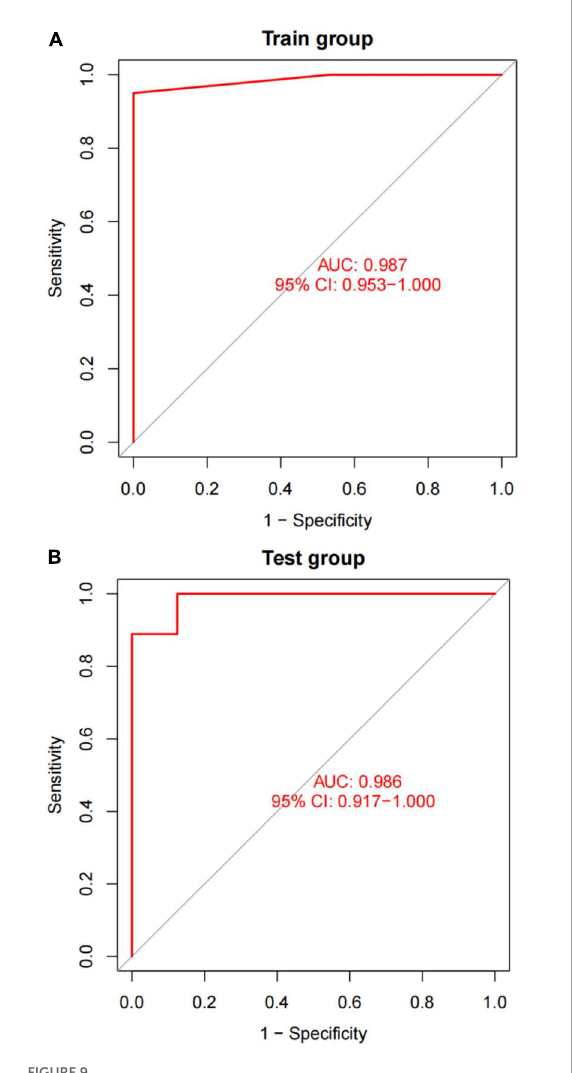
FIGURE9 A plot of the results of AUC verification. (A) AUC verification in the training dataset. (B) AUC verification in the test dataset. The ROC curve illustrates the suitable threshold points, while the values in parenthesis represent the sensitivity and specificity. The AUC value represents the area under the ROC